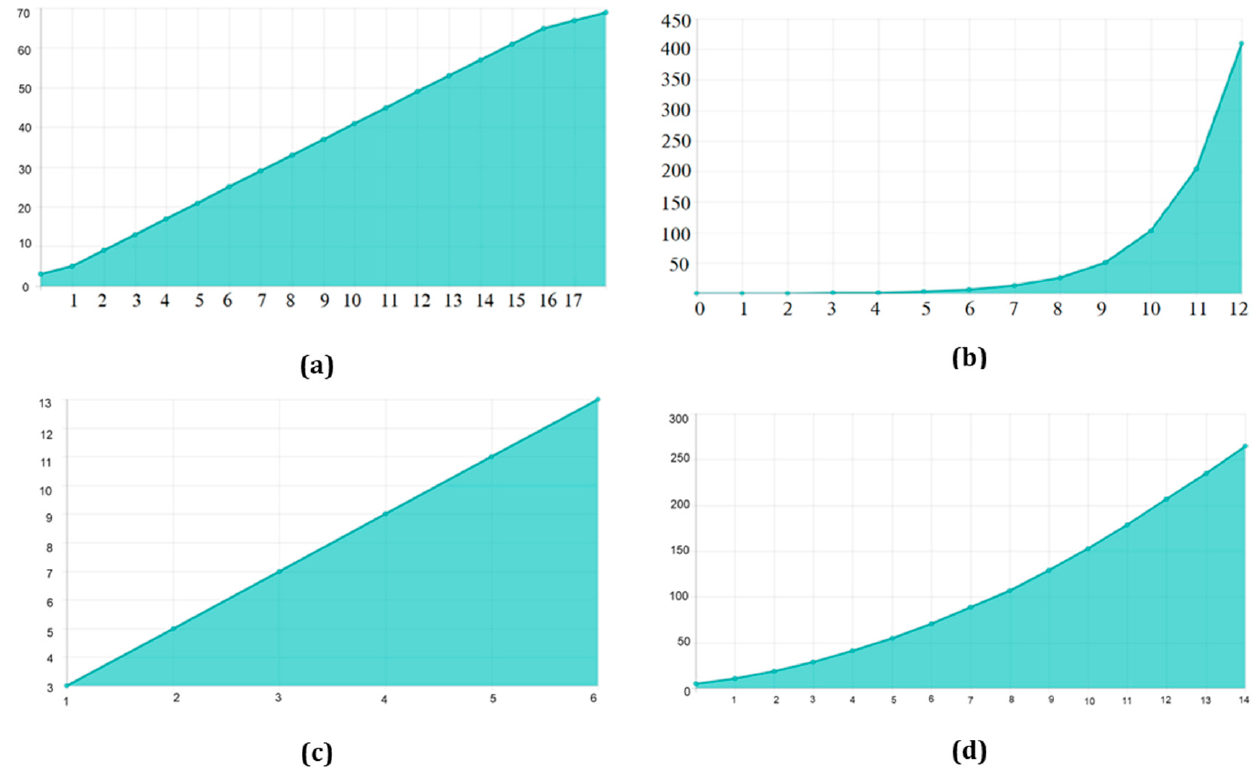
Figure 7. Receptive Field Growth Layer vs. Receptive Field Number: ( a ) Stride (S) = 1, dilation 1, 1, 2, 2, 2, 2 ( b ) S = 2, dilation 1, 1, 2, 2, 2 ( c ) S = 3, dilation 1, 1, 2, 2, 2 ( d ) S = 4, dilation 1, 1, 2, 2, 2